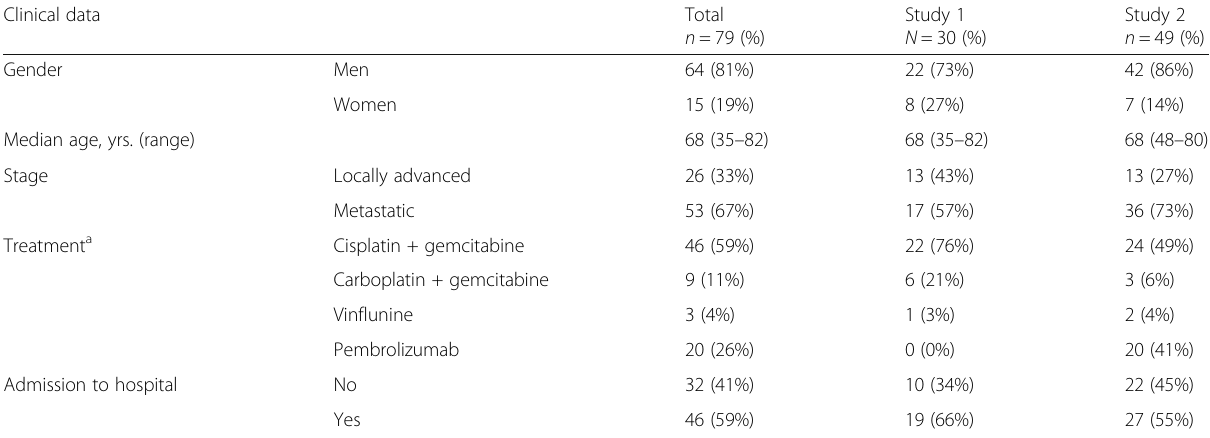
Table 1 Patient characteristics from study 1 and 2 Clinical